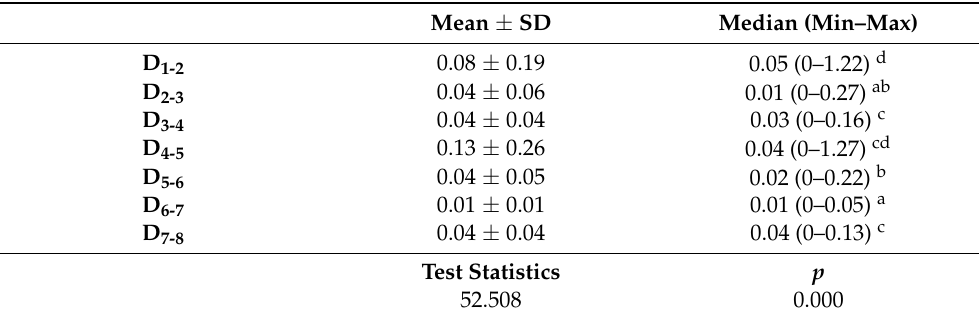
Table 3. Distance deviations between adjacent implants for entire impression